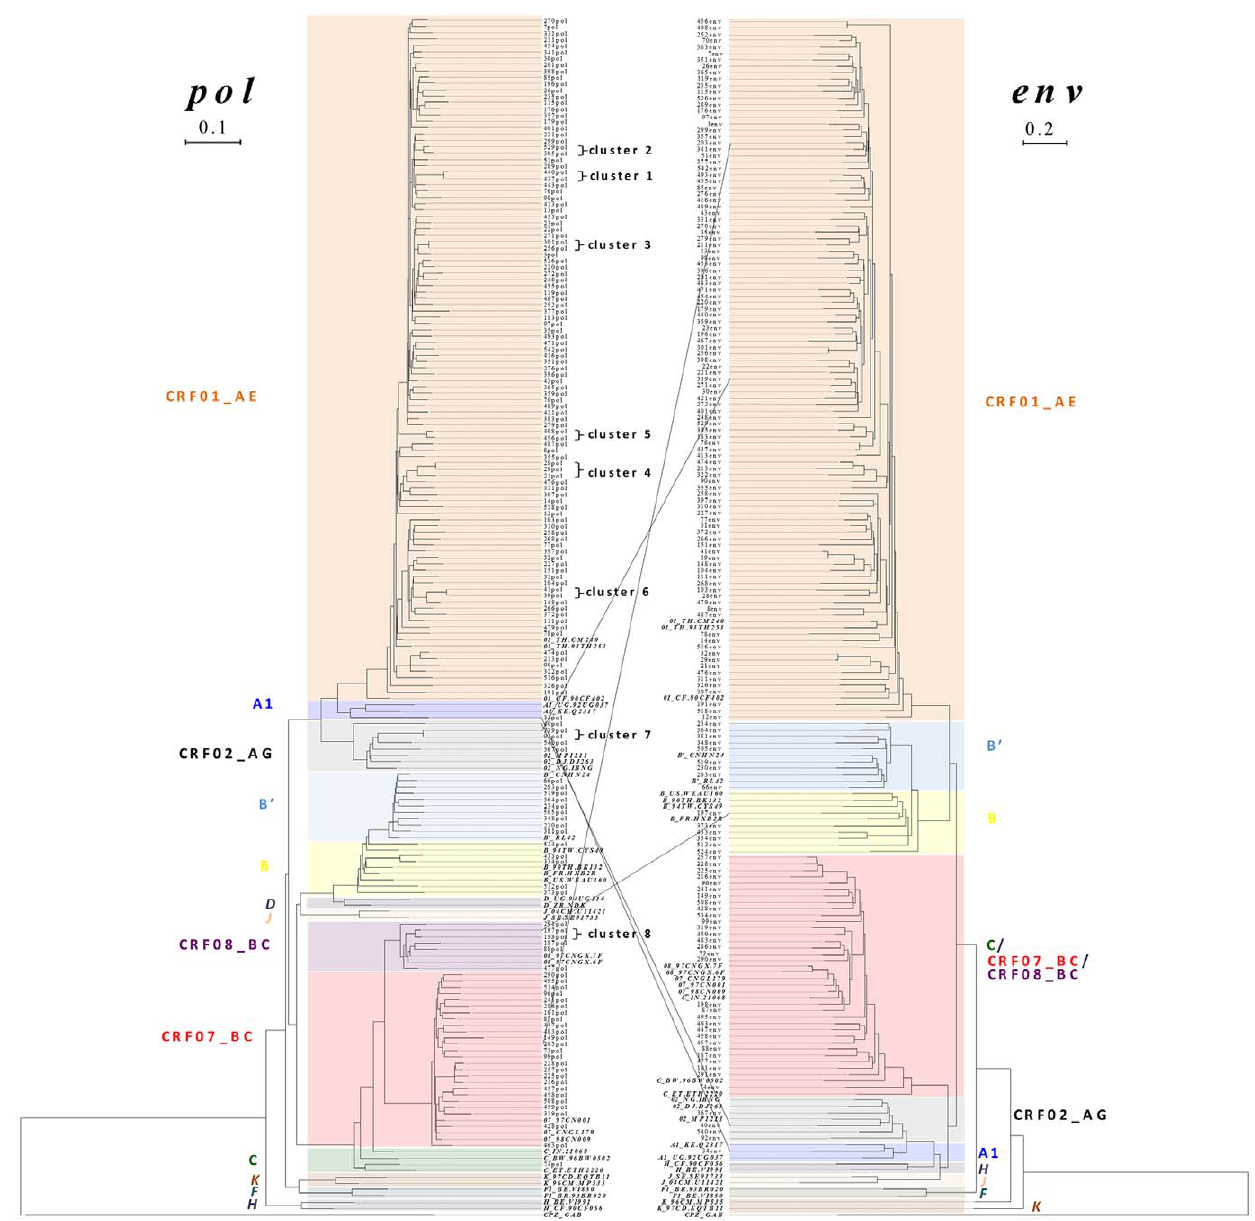
Figure 2. Phylogenetic tree (maximum likelihood) and genotypes of HIV-1 in Guangdong’s patients. Continual lines connected the inter-subtype recombination sequences of pol (left) and env (right) trees from the same